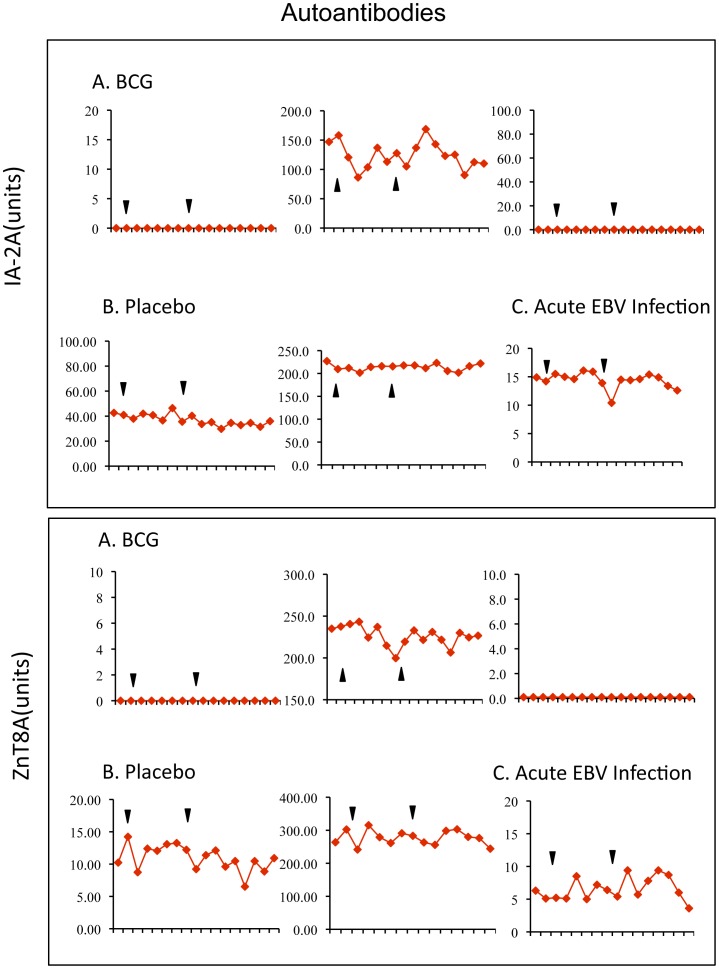
IA-2A and ZnT8 autoantibodies in clinical trial subjects by study week.